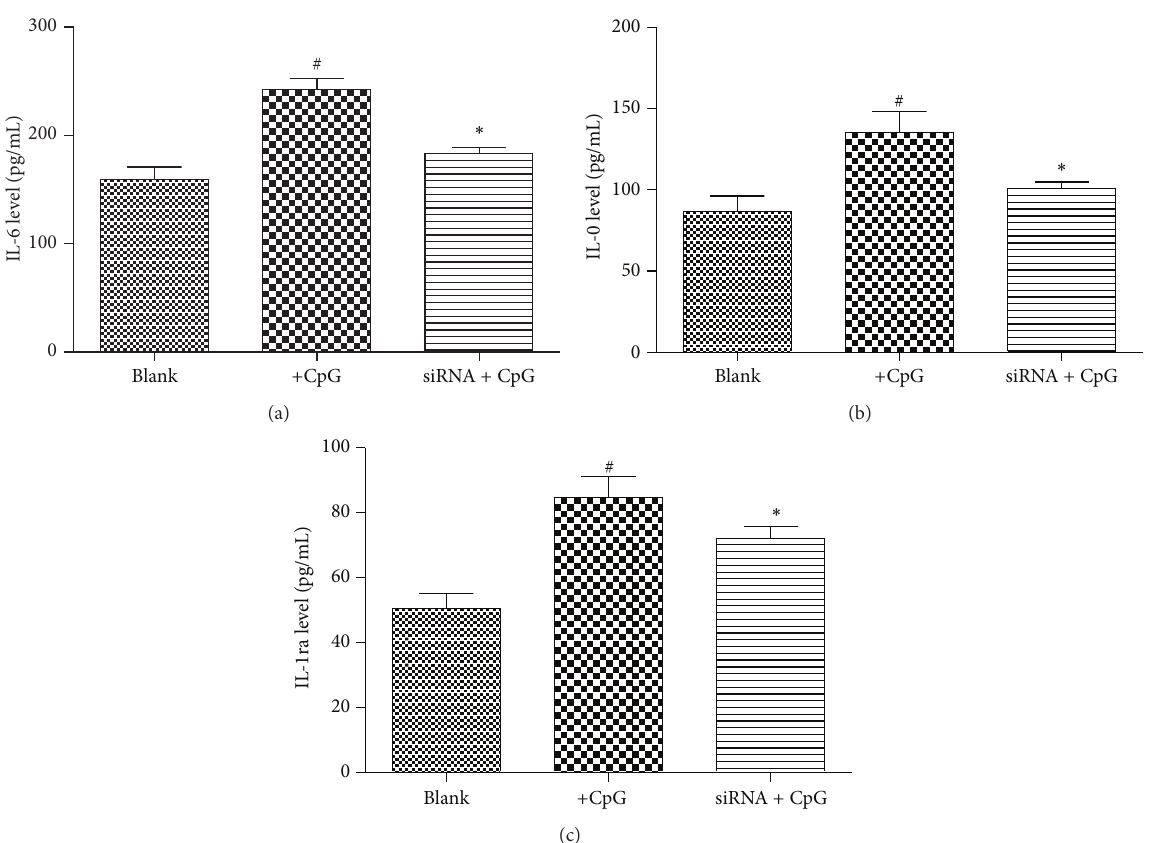
Figure 4: Effects of TLR9 expression on cytokines secretion in CpG stimulated B cells. (a)–(c) When SLE-isolated B cells were stimulated by CpG, secretions of IL-6, IL-10, and IL-1r 𝛼 were significantly increased compared with the Blank group; however, this effect was reversed by siRNA-TLR9 transfection. Cells in Blank group were SLE-isolated B cells. # 𝑃 < 0.05 compared with the Blank group, and ∗ 𝑃 < 0.05 compared with the CpG group.